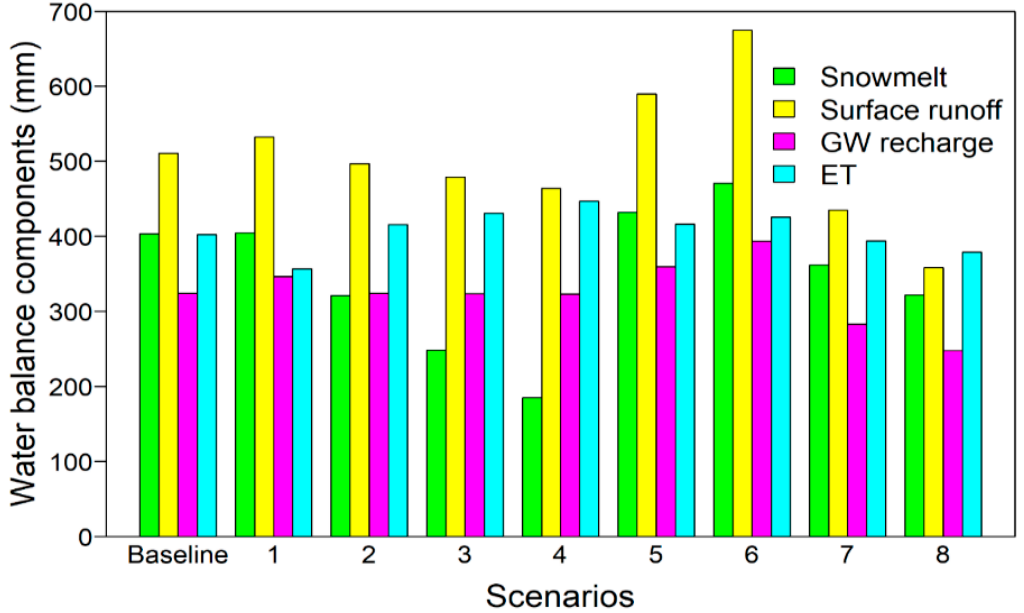
Figure 6. Values of water balance components (mm) under di ff erent climate change scenarios. GW, groundwater; ET, evapotranspiration.